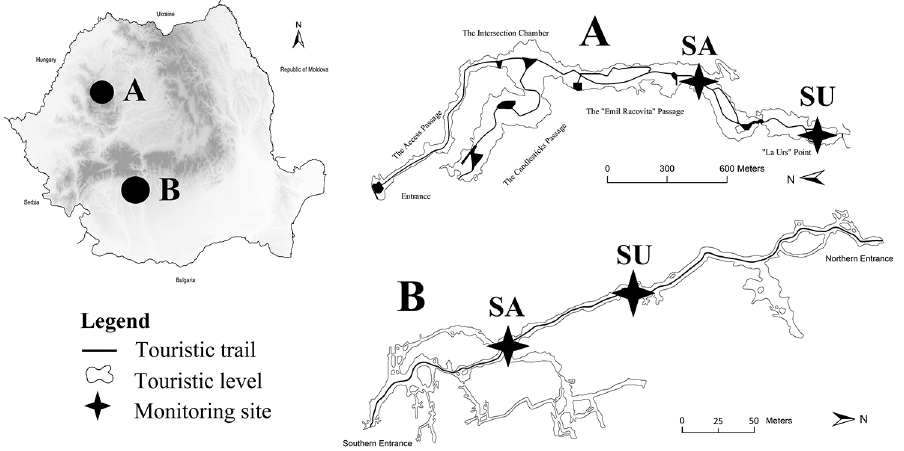
Figure 1. Monitoring sites; Location of the studied caves in Romania with the cave maps and monitor- ing sites in Ursilor ( A modified after Rusu and Racoviţă 1981) and Muierilor ( B modified after map by Grigore, Fofirică, Dăscălescu and Iliescu,